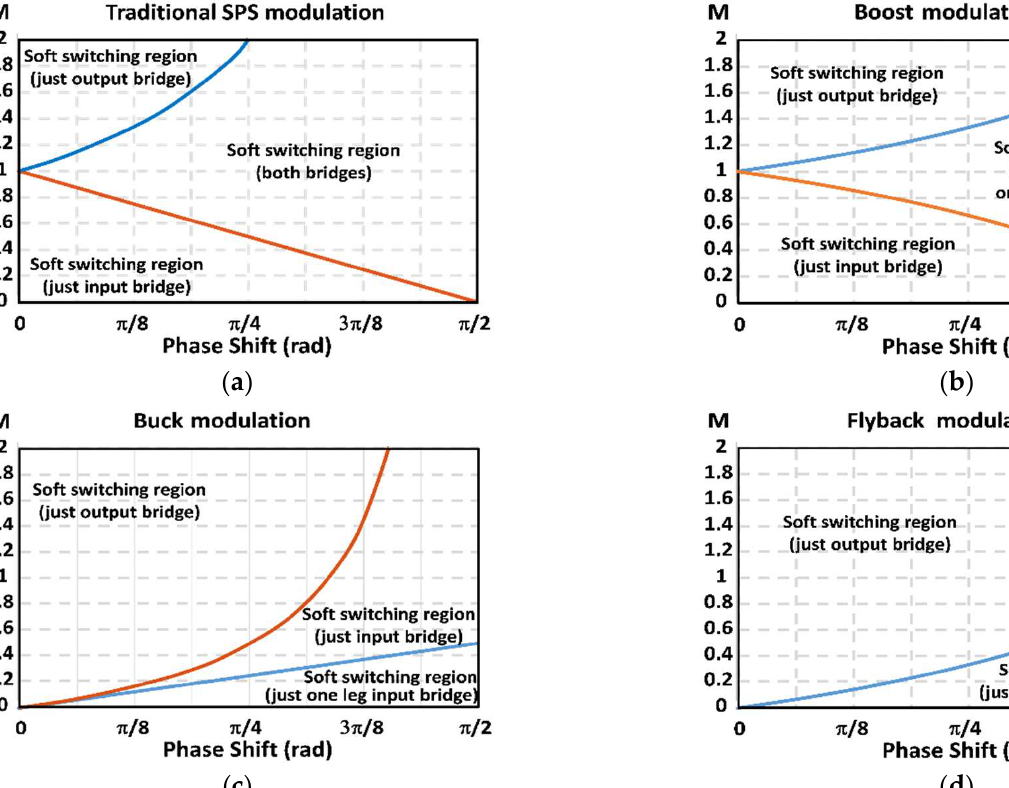
Figure 7. Soft switching regions: ( a ) traditional SPS modulation, ( b ) boost modulation, ( c ) buck modulation, and ( d ) flyback modulation.